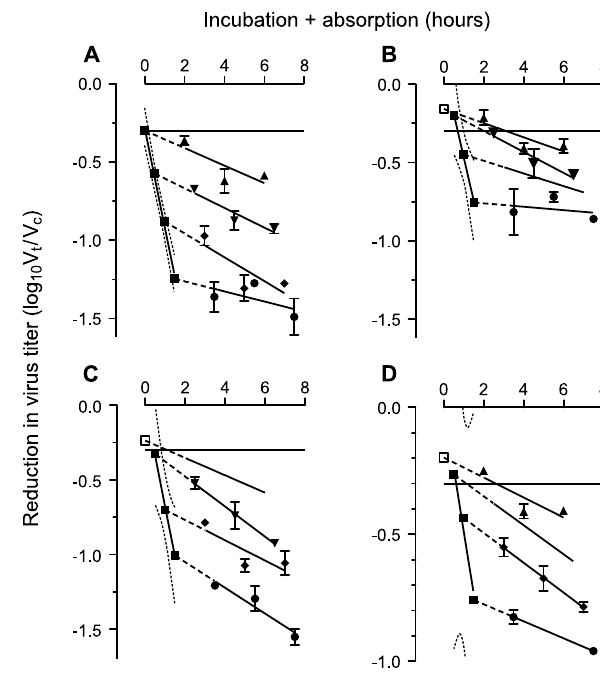
Figure 3. Incubation plus absorption plots of HIV-1 SF162 neutralization with sera from protected macaques. Sera are taken two weeks before challenge. Reductions in infectious virus are calculated as ratio of the titer (V t ) at time t for the virus exposed to serum from an immunized macaque divided by the titer (V c ) at the same time for a control serum. The ratio is transformed to log 10 (V t /V c ). Incubation and absorption phases are measured in hours. Data are displayed as means with standard errors. Solid horizontal line represents 50% neutralization. Triangles, diamonds and discs: regres- sion lines for absorption plots following incubation for different intervals. Some symbols are excluded to improve clarity. Intercepts determined (straight dotted lines) giving reduction in virus titer when absorption is zero ( ; end of incubation phase) and plotted as solid squares. Regression line with 95% confidence band (curved dotted lines). Open squares are data which have been excluded from calculation of regression line. A . Macaque in treatment group 2.1: 1 in 40 dilution of serum: Reduction during incubation phase of log 10 0.6292 6 0.02930 infectious doses per hour starting at log 10 2 0.3948